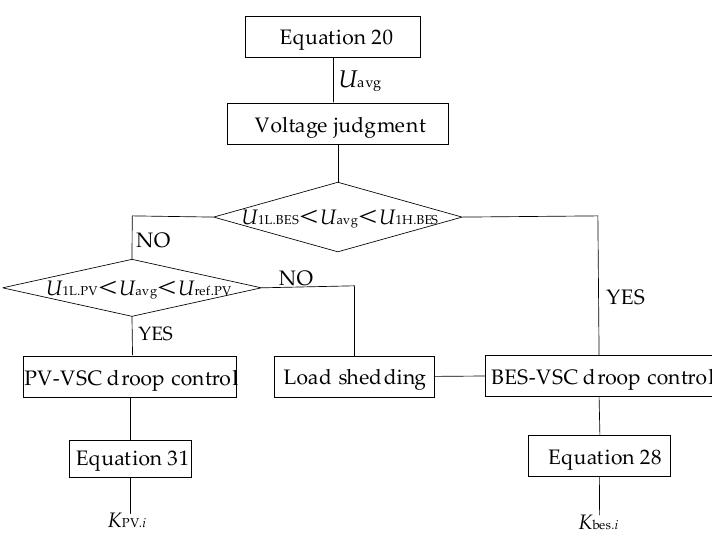
Figure 11. Multi-mode switch strategy based on virtual bus voltage information.